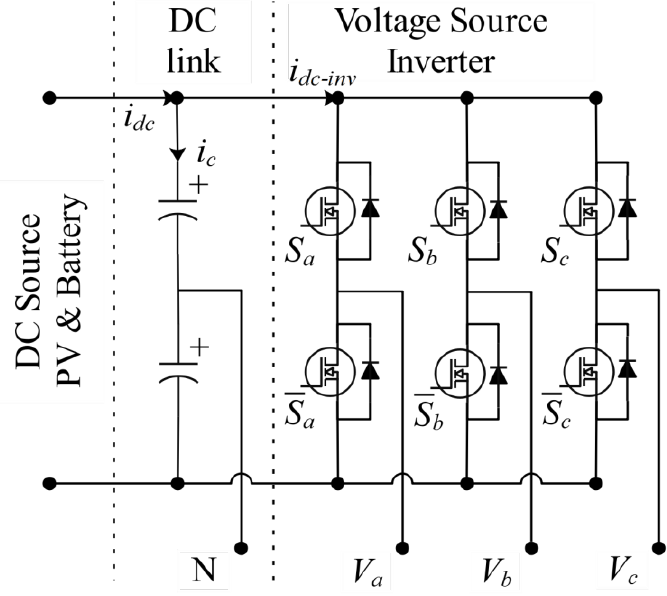
Figure 12 . Model of the split DC link three-phase, four-wire inverter topology. Figure 12. Model of the split DC link three-phase, four-wire inverter topology.